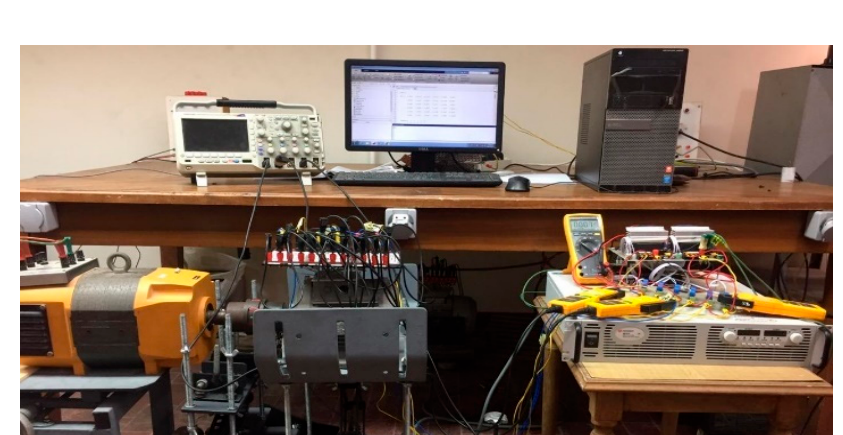
Figure 5. Experimental six-phase setup.